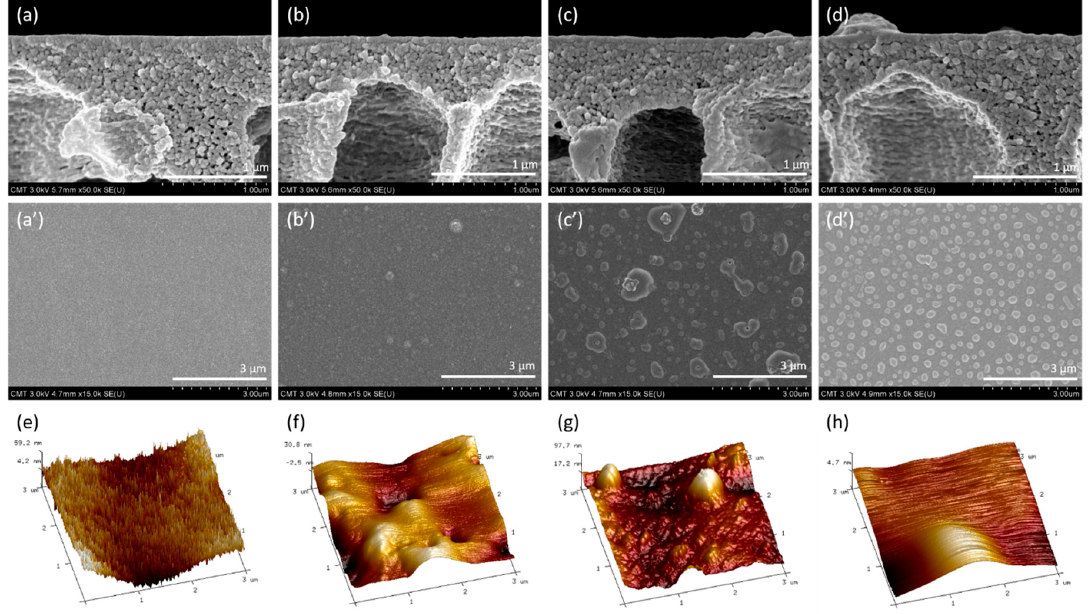
Figure 4. The morphology of surface/cross-section of TFC membranes, PAN support ( a / a ′ ), PIP ( b / b ′ ), PIP–PEI ( c / c ′ ), and PIP–Z ( d / d ′ ) as obtained from FESEM images and AFM images of PAN support ( e ), PIP ( f ), PIP–PEI ( g ), and PIP–Z ( h ).